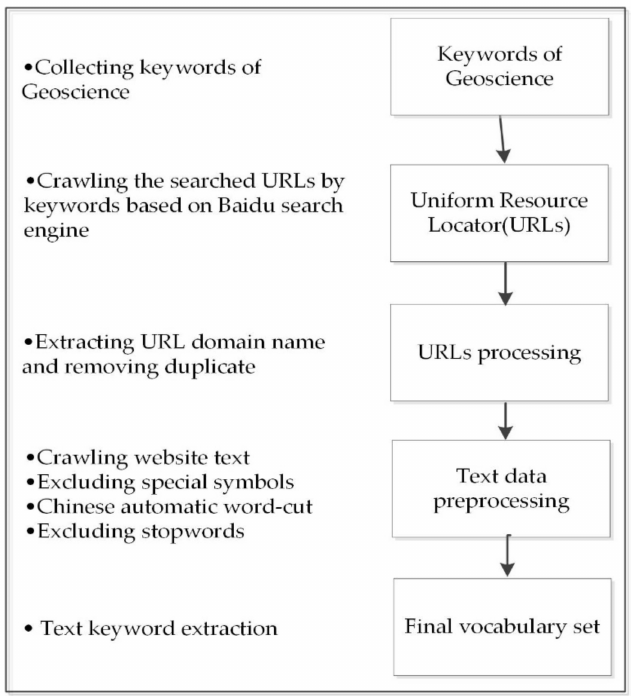
Figure 2. Keyword-based GDSW acquisition and pre-processing process.